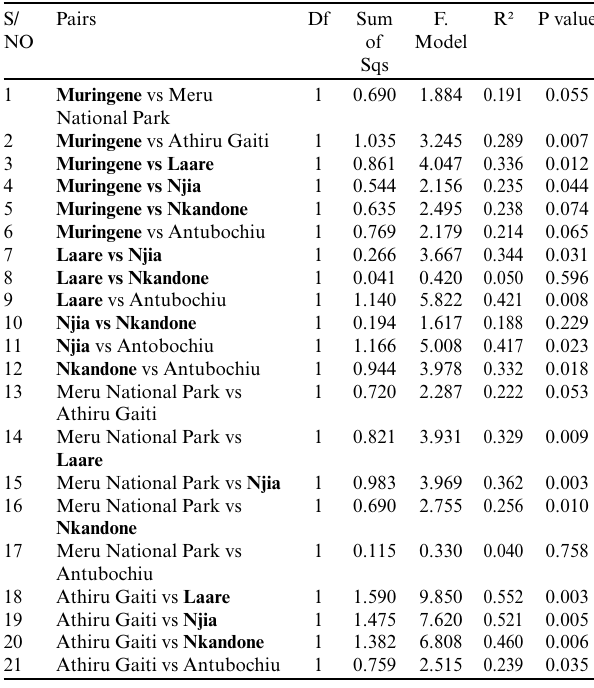
Table 2 . Pairwise comparison in khat ( Catha edulis ) is for all pesticide residues found in each specific site, n= 7. Bolded names indicate traditional production system whereas unbolded names indicate commercial production